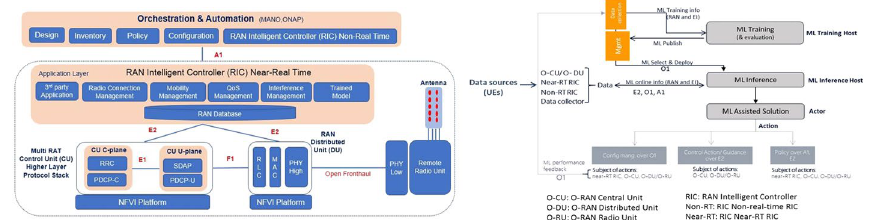
Fig. 5 ML training host and inference locations in O-RAN